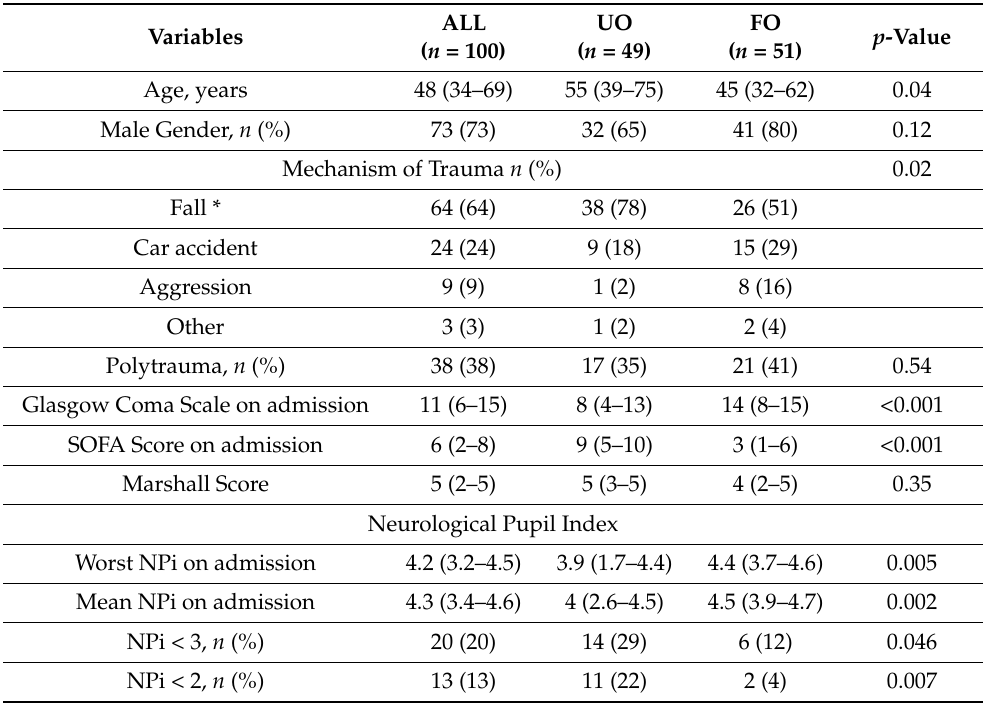
Table 1. Characteristics of the study population, according to neurological outcome at hospital discharge. Data are presented as count (%) or median (25th–75th percentiles); differences for cat- egorical variables were assessed using the chi-square test (or the Fisher’s exact test when n < 10), while for continuous variables the Mann–Whitney U-test was used. UO = Unfavorable Outcome; FO = Favorable Outcome; NPI = Neurological Pupil Index; SOFA = Sequential Organ Failure Assess- ment; CT = Computed Tomography; CH = Change (percentage of constriction); COPD = Chronic Obstructive Pulmonary Disease; AHT = Arterial Hypertension; ECMO = Extracorporeal Membrane Oxygenation; ICP = Intracranial Pressure; ICU = Intensive Care Unit; IMPACT = International Mis- sion for Prognosis and Analysis of Clinical Trials in TBI. * indicates fall from more than 3 m. Fall from smaller height are included into